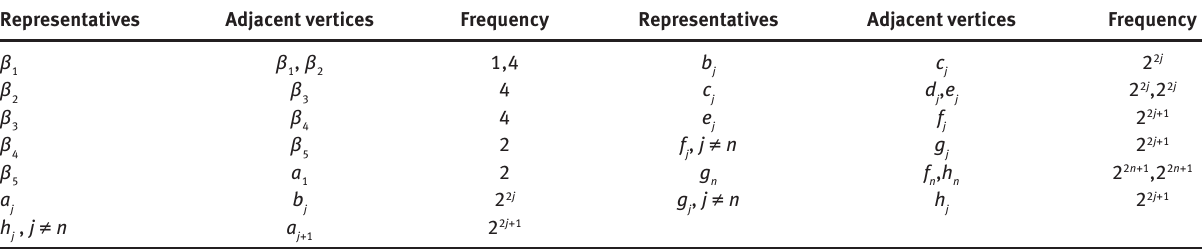
Table 3: Representatives with corresponding adjacent vertices and their frequencies of occurrence for n ≥ 1. Representatives